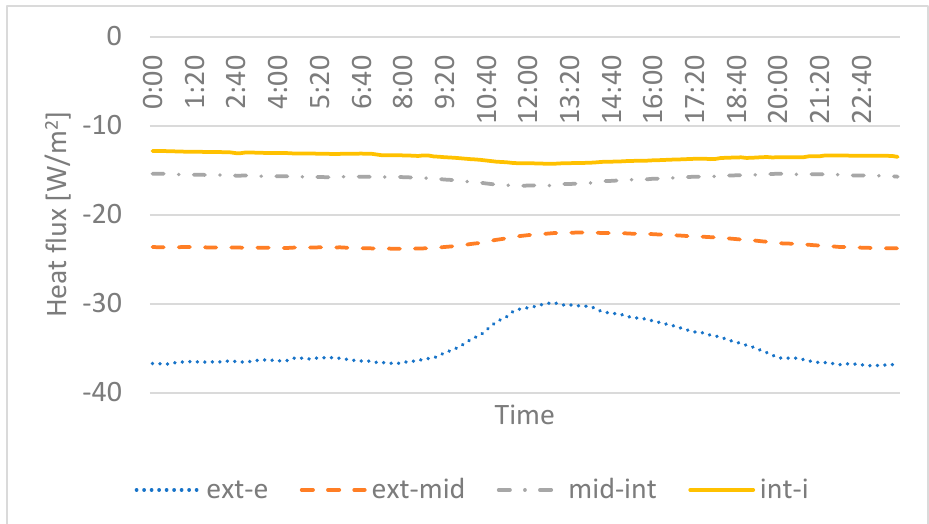
Figure 14. Heat fluxes between the layers on 27 June 2021. According to the drawing, the positive heat flux on the ext-e surface means the heat flows into the wall, and on the int-i surface inversely. The heat flux flows into the wall from both sides due to solar radiation and internal temperature. This stream then flows across the boundary between the outer and middle layers. A stream of heat enters the wall also from the inside. In the evening hours, the heat drains off, especially outside the wall. Approximately 5 h after the maximum flux flowing to the wall through the ext-e surfaces, the direction of heat flow through the int-i surfaces changes and the room is heated [31]. The chart for 8 January is shown in Figure 15.